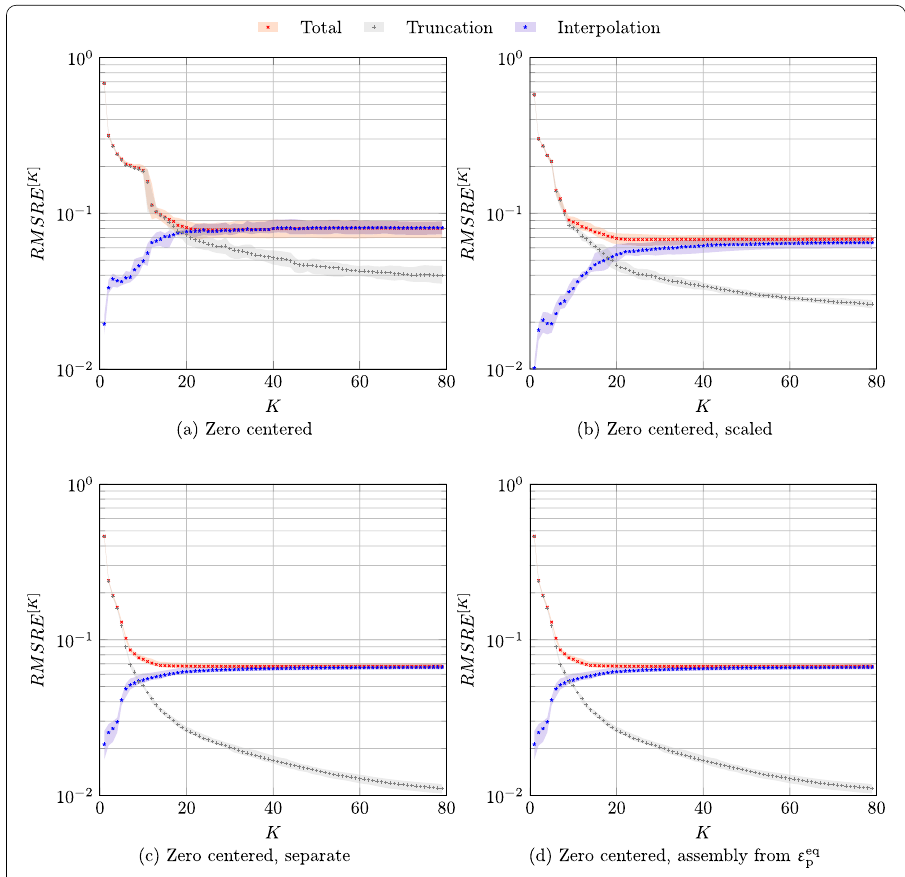
Fig. 11 RMSRE of the strain field of the industrial bending problem using 4 different methods for surrogate model construction. The markers represents the mean over the 5 training sets. The shaded area represents the range over all training